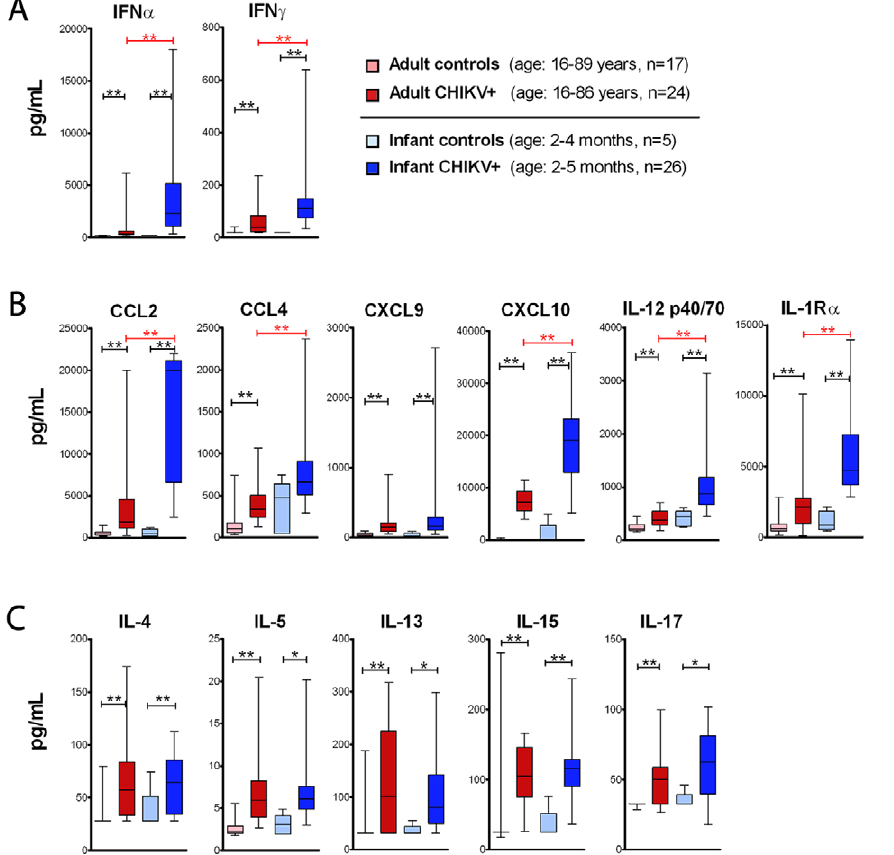
Figure 1. Serum concentration of IFN and IFN-induced chemokines is higher in CHIKV infected infants as compared to adults. Patient sera were obtained from acute CHIKV infected adults (age=16–86 years) and infants (age=2–5 months). Age matched controls from La Re´union were tested. Chemokines / cytokines were measured using a Luminex assay. ( A ) IFN a and IFN c levels; ( B ) IFN-induced molecules; and ( C ) Lymphocyte cell derived cytokines are shown. Whisker-box plots are shown (line indicates median; boxes represent first and third quartile; and bars define range). Mann-Whitney U-test was performed using a false discovery rate (FDR) procedure for generating corrected p-values. Comparisons were made between CHIKV patients versus their control cohort (in black); as well as adult versus infant patients (in red). ** indicates p , 0.005, * indicates p , 0.05. IFN a data from adult patients were previously reported [20], but are shown here for comparison to data from infected neonates.